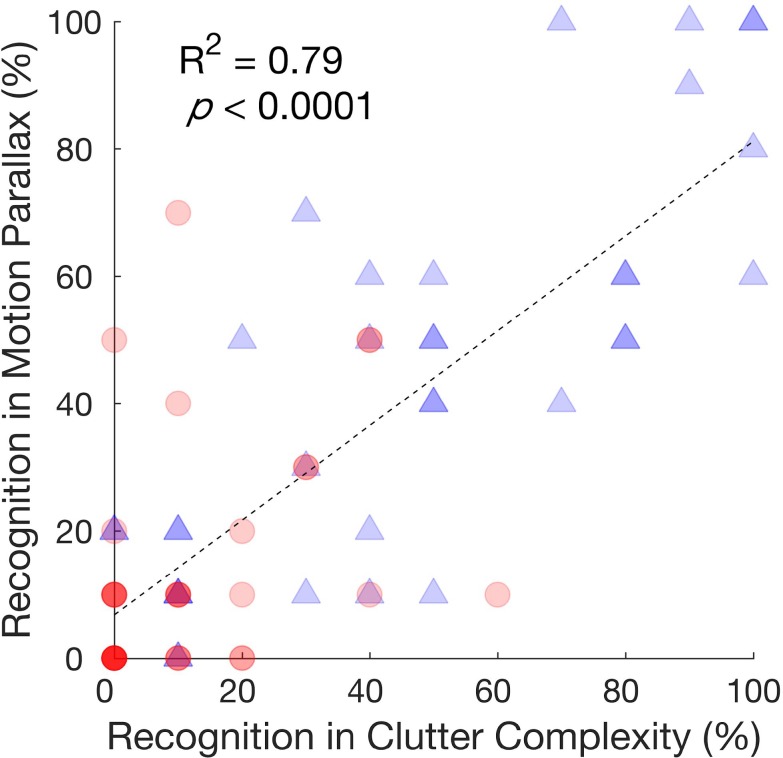
Recognition rate of the same images collected in the Clutter Complexity (x-axis) and the static condition of the Motion Parallax (y-axis) experiments. The blue triangles are from the no clutter and static condition, and the red circles show the recognition rates with the cluttered background. Each point represents the responses to one object under the corresponding condition (70 points in total). The points may overlap indicating the same recognition rates among the objects. The darker the icon is, the more points are overlapping. For example, the majority recognition rates from the cluttered condition are either 0% or 10%. The recognition rates in the two experiments are significantly correlated.